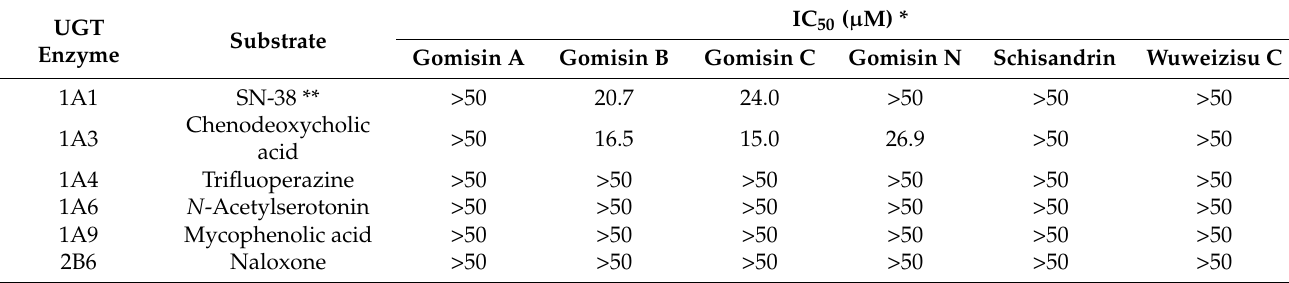
Table 5. Inhibitory effects of six lignans against six uridine 5 (cid:48) -diphosphoglucuronosyl transferase (UGT) enzymes.